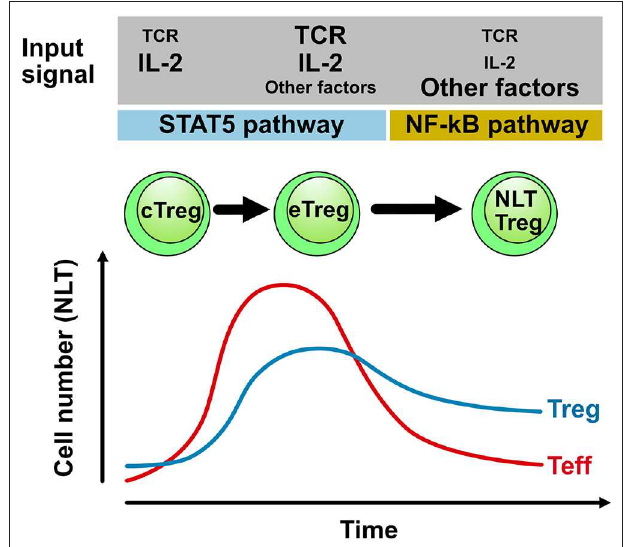
FIGURE 1 | Population dynamics and maintenance of Treg cells in NLTs. During an adaptive immune response in NLT (e.g., in the central nervous system during EAE) conventional T cells (Teff) infiltrate the target tissue and expand providing sufficient IL-2 to also drive the differentiation and expansion of Treg cells. After contraction of the conventional effector T cell (Teff) population (due to active regulation by Treg cells), IL-2 becomes limiting and persisting Treg cells likely depend on alternative signals for self-renewal. Here, signals that activate the NF- κ B pathway might be important cues not only for NLT function but also for their maintenance ( 31). TCR triggering of Treg cells and downstream modulation of the TCR signal by the transcriptional modulator IRF4 is a non-redundant event in the differentiation of central Treg cells (cTreg) in secondary lymphoid tissues into effector Treg cells (eTreg) in the inflamed tissue. The requirement of the TCR signal and other cues in NLT Treg cells that reside in specific niches over extended periods of time needs to be determined and likely depends on the anatomical niche that might then also drive a distinct functional specialization of NLT Treg cells.